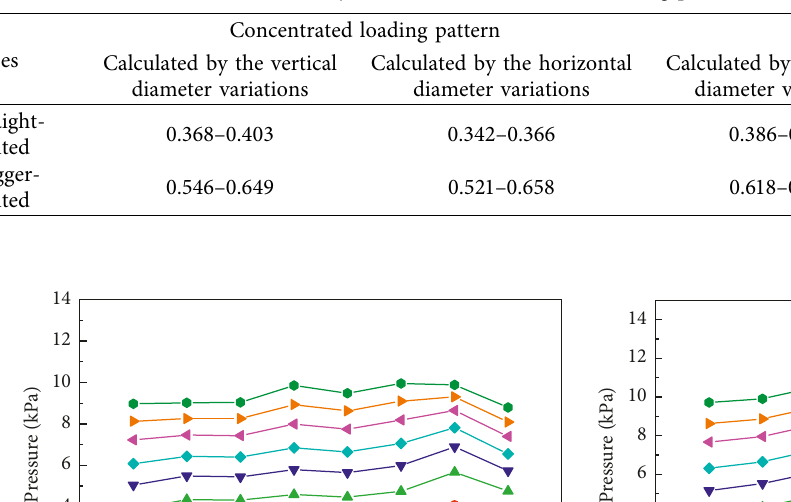
Table 2: Values of η based on the concentrated loading pattern and realistic loading pattern.